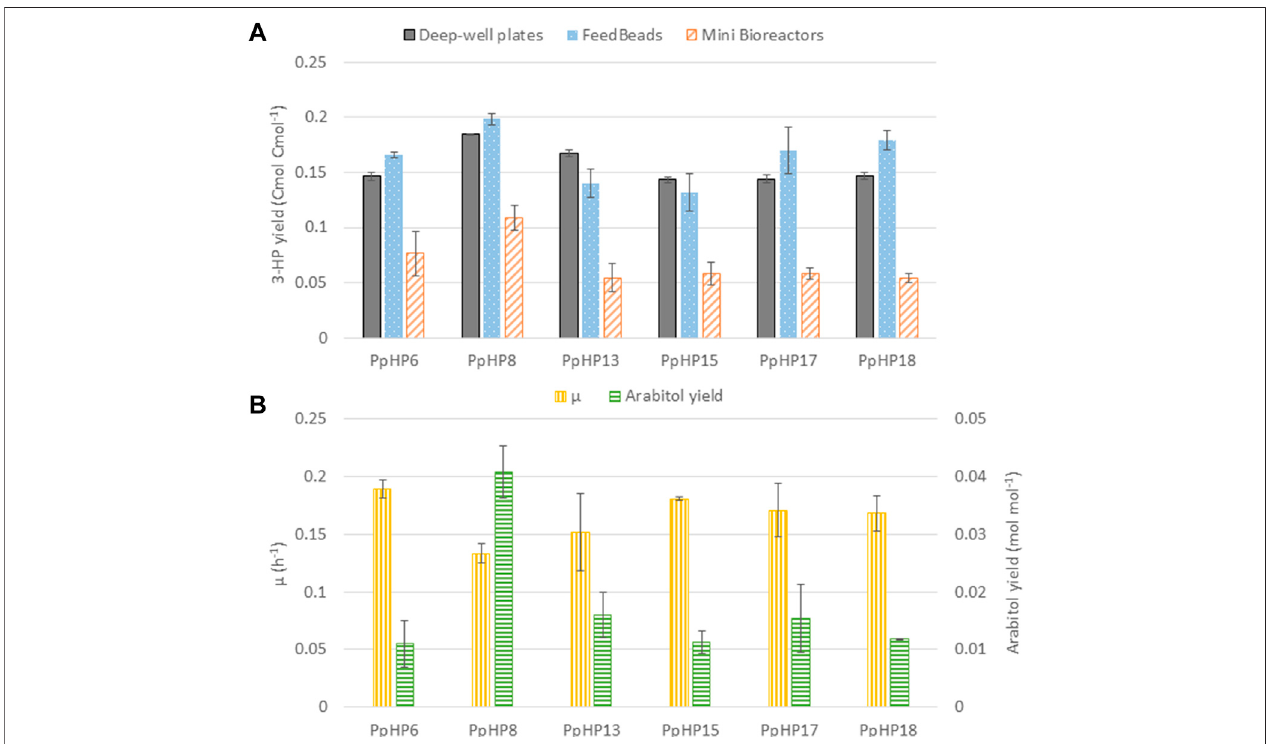
FIGURE3| Comparison ofthemost relevant3-HP producing P.pastoris strains under three differentscreeningconditions. (A) 3-HP production yieldin deep-well plates(greysolidbars),FeedBeads ® (bluedottedbars),andminibioreactors(orangestripedbars). (B) Growthrate(yellowverticallystripedbars)andarabitolproduction yield (green horizontally striped bars) for each strain grown in mini